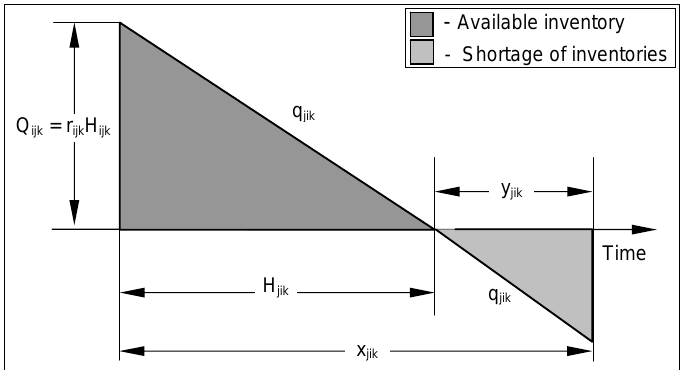
Figure 5. A scheme of the inventories of goods (k) at the consumer (j) after arrived from the manufacturer